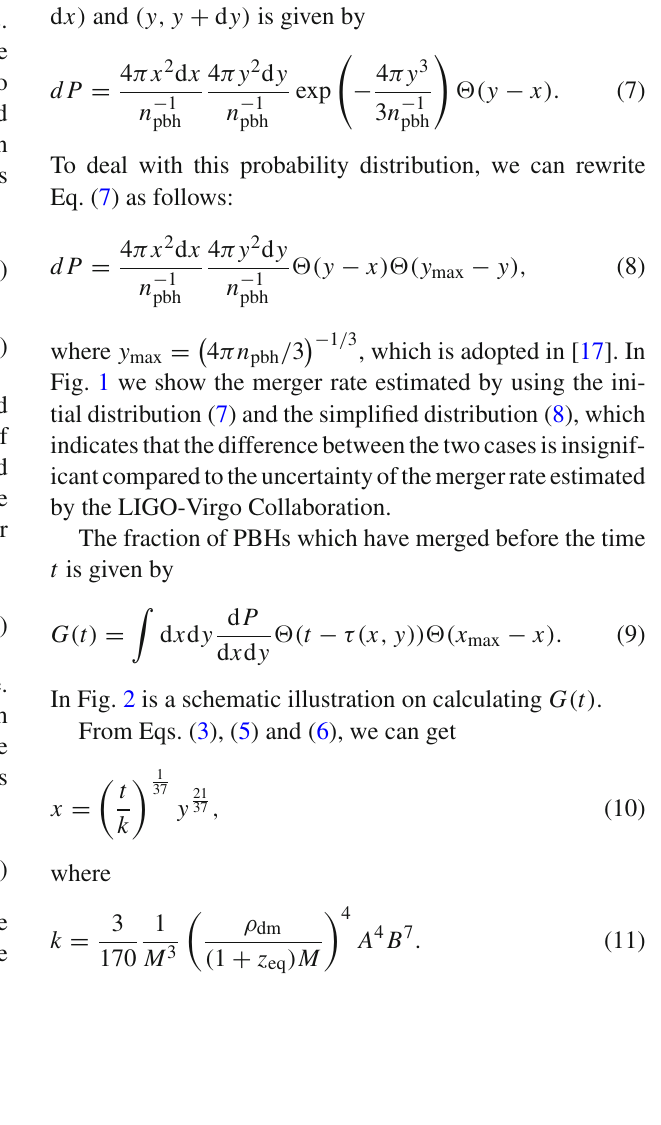
spatial distribution of PBHs is random, the probability that